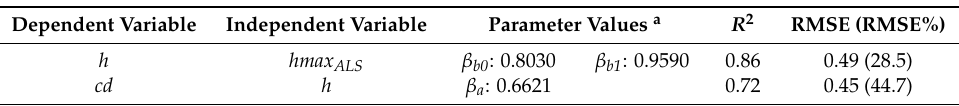
Table 4. Regression model variables, parameter values and goodness of fit. RMSE from leave-on-out cross-validation.